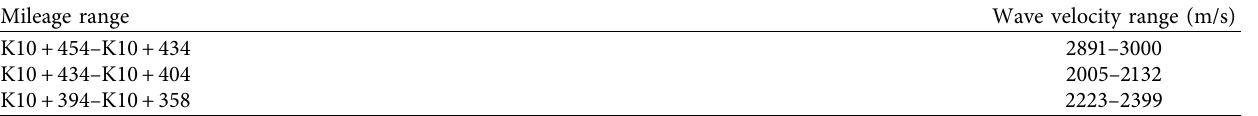
Table 1: Wave velocity range in each